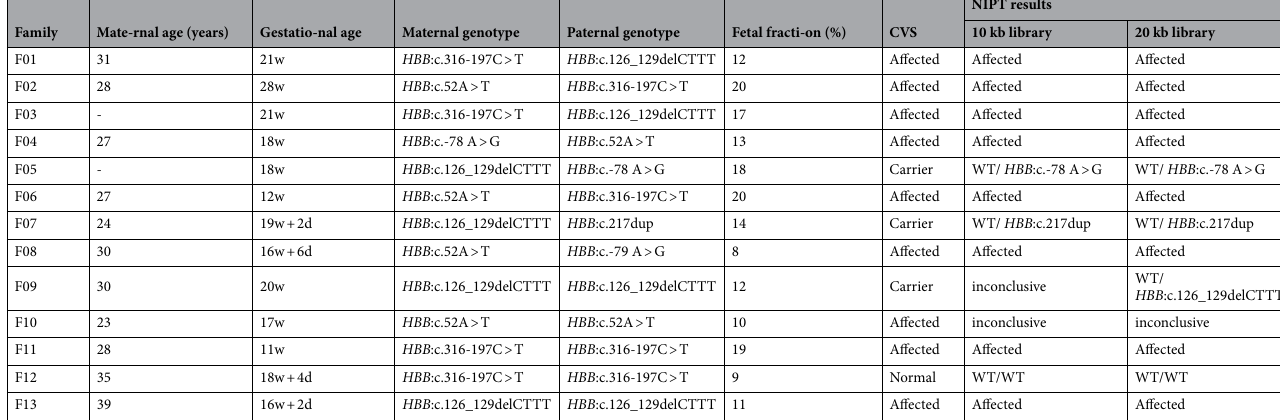
Table 1. Summary of family information and NIPT results included in this